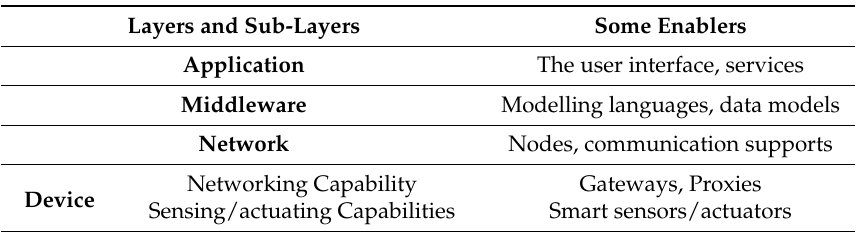
Table 1. Simplified view of the IoT layered model. Adapted from